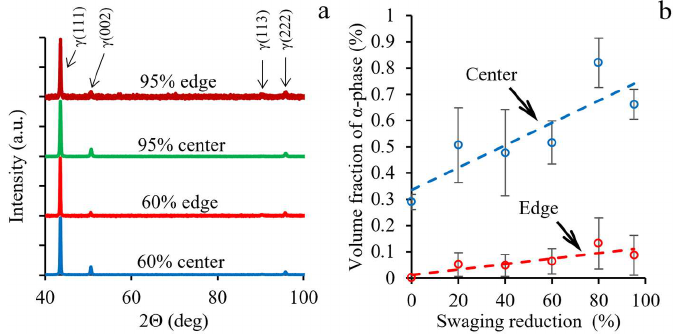
Figure 2. ( a ) X-ray patterns and ( b ) α-phase fraction after different swaging modes. The dashed lines in 2b are only guides to readers.